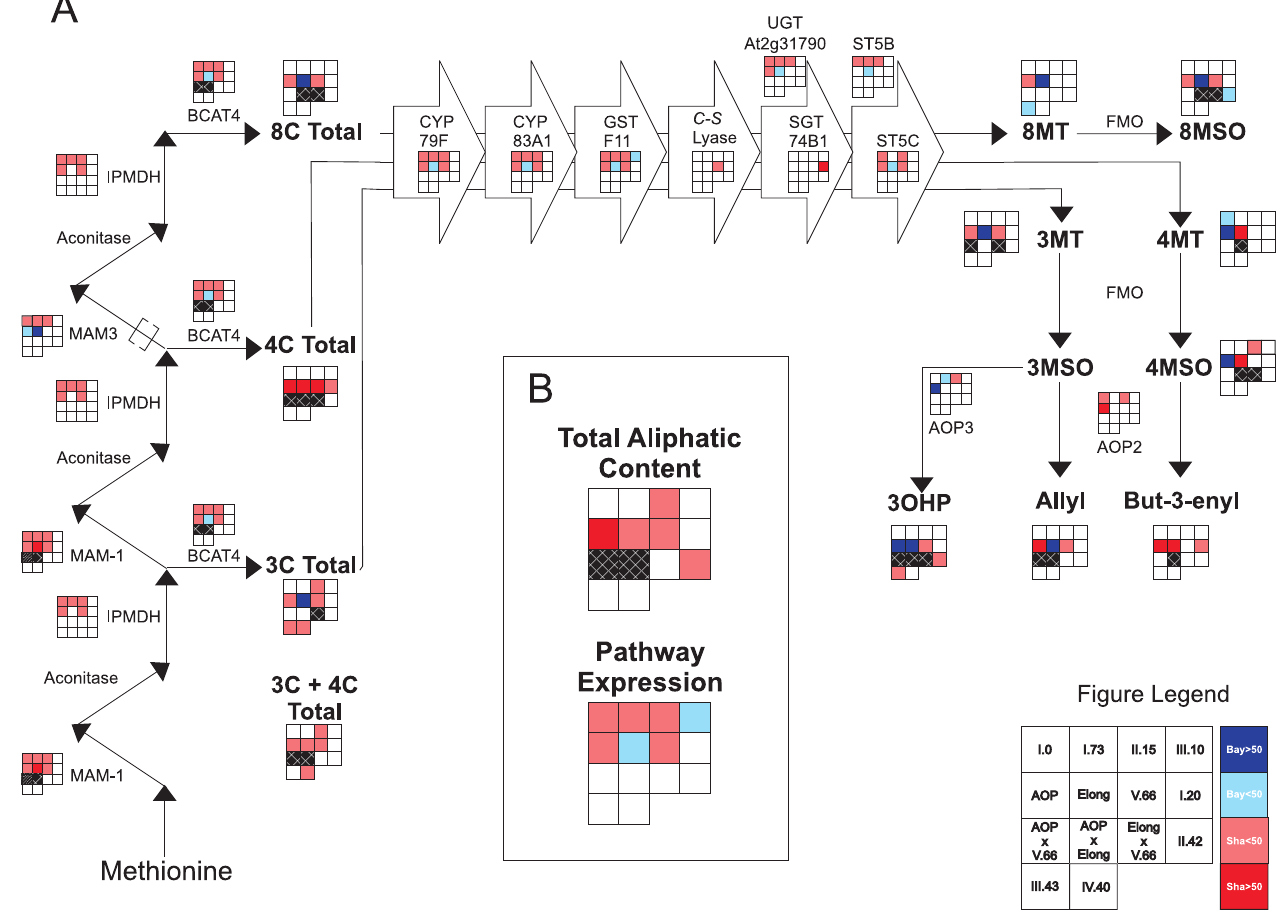
Figure 4. Pathway Summary of Aliphatic Glucosinolate QTLs Results of ANOVA testing of all identified aliphatic glucosinolate QTLs for significant impact upon the accumulation of individual glucosinolate metabolites, transcript level of all biosynthetic genes, total aliphatic glucosinolate content, and the average expression of the aliphatic glucosinolate biosynthetic pathway is presented graphically. The genes and metabolites are shown with respect to the currently theorized biosynthetic pathway. Trait abbreviations are as listed in Table S1. Gene names are as listed in Table S3, and TAIR locus identifiers are used for gene families where there is no settled naming system. Cells within boxes represent aliphatic glucosinolate QTLs. The legend at the bottom right contains the QTL name. Cells representing QTLs significantly controlling the represented trait are colored to show the directionality of the allele substitution effect; a positive effect of the Bay-0 allele is blue, and a positive effect of the Sha allele is red. Dark red and dark blue show that the allele substitution at the given QTL led to greater than 50% phenotypic change in the trait, while the lighter colors represent QTLs of smaller phenotypic effect. Significant epistasis between the GSL.Aliph.AOP , GSL.Aliph.Elong, and GSL.Aliph.V.66 QTLs are shown by black cross-hatching within the respectively labeled cell. For example, but-3-enyl is controlled by QTL at GSL.AOP , GSL.Elong, and GSL.I.20 with epistasis between the GSL.AOP and GSL.Elong loci. QTLs for gene expression are shown in smaller font with a smaller ANOVA box, while QTLs for metabolites are shown in bold larger font with a larger box. (A) QTLs for the whole pathway broken down into individual metabolites and transcripts. (B) QTLs for total aliphatic glucosinolate content and the mean z -score for the biosynthetic pathway.